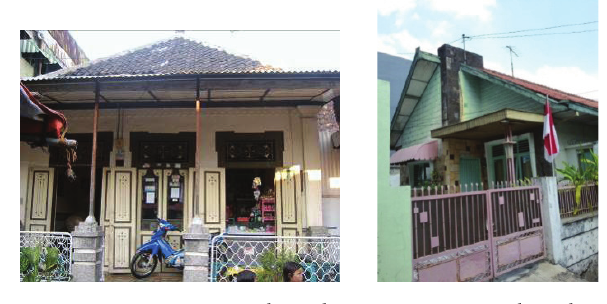
Figure 5. Javanese Vernacular style Figure 6. Jengki Style